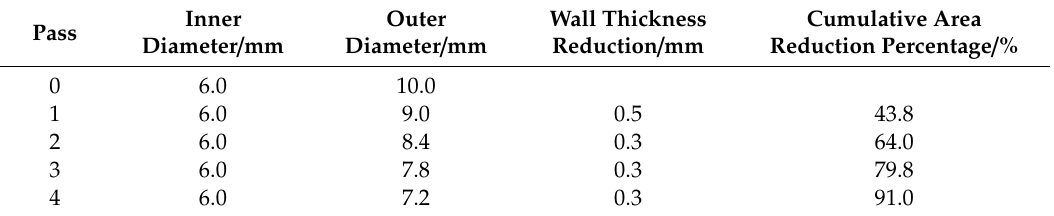
Table 2. Reduction of thickness and area reduction percentage during deformation.